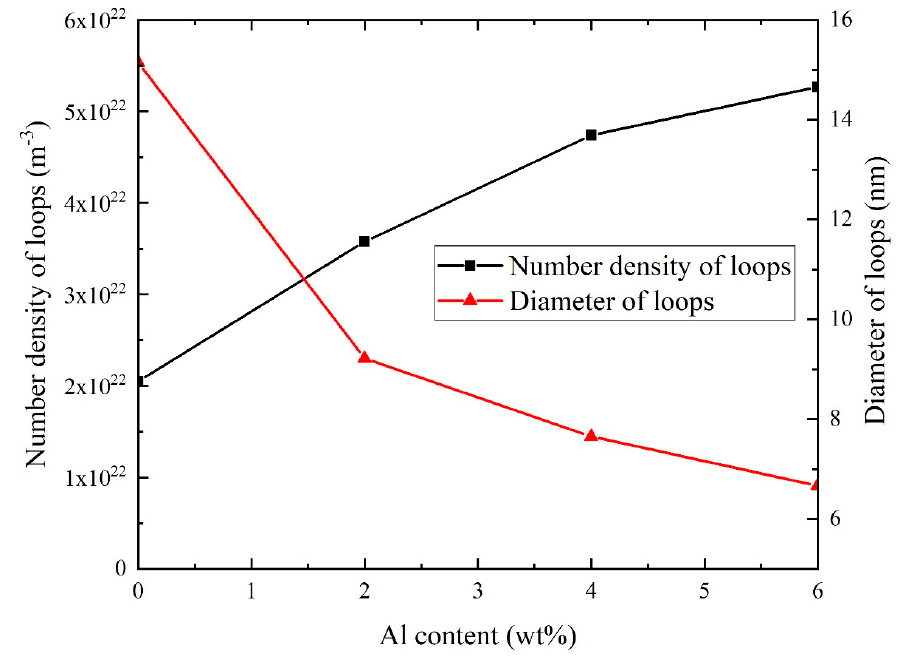
Figure 6. Number density and diameter of dislocation loops in bcc Fe-12Cr-xAl (x = 0,2,4,6) irradiated to peak dose of 1dpa at 330 °C with argon ions.